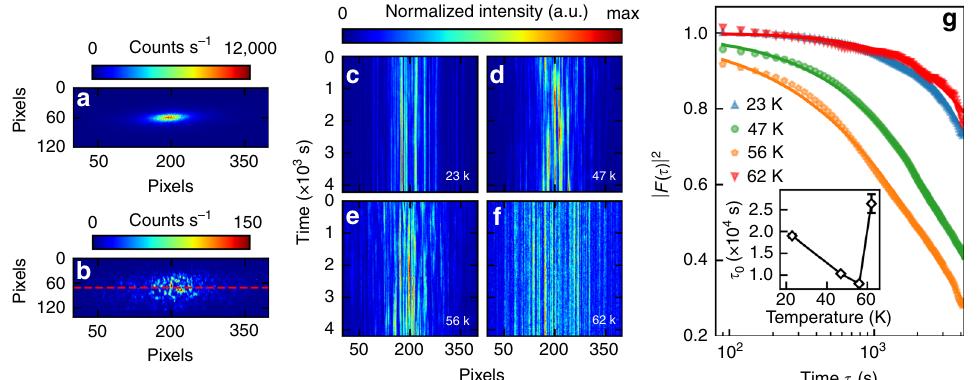
Fig. 3 Mesoscopic dynamics of charge domains. a , b Images of CDW diffraction signal taken at 45 K without ( a ) and with ( b ) the 10 μ m pinhole (see text). Due to the much lower count rate in b , the image is obtained from an average of three frames, each with 10 s of exposure time. c – f Waterfall plots (see text) of the time series of diffraction intensities extracted from a horizontal strip taken near the dashed line in b . Global intensity variations over time (Supplementary Fig. 7) have been compensated by normalizing the mean intensity of each time frame. g Autocorrelation of speckle patterns at different temperatures. The inset shows fi tted values of the coherence time τ 0 (see text) that characterizes the rate of domain motion. Error bars in the inset represent uncertainties (1 s.d.) obtained from least-square fi tting of the data. The autocorrelation at 62 K may exhibit some initial rapid decay (Supplementary Fig. 8) that is not accounted for by the fi